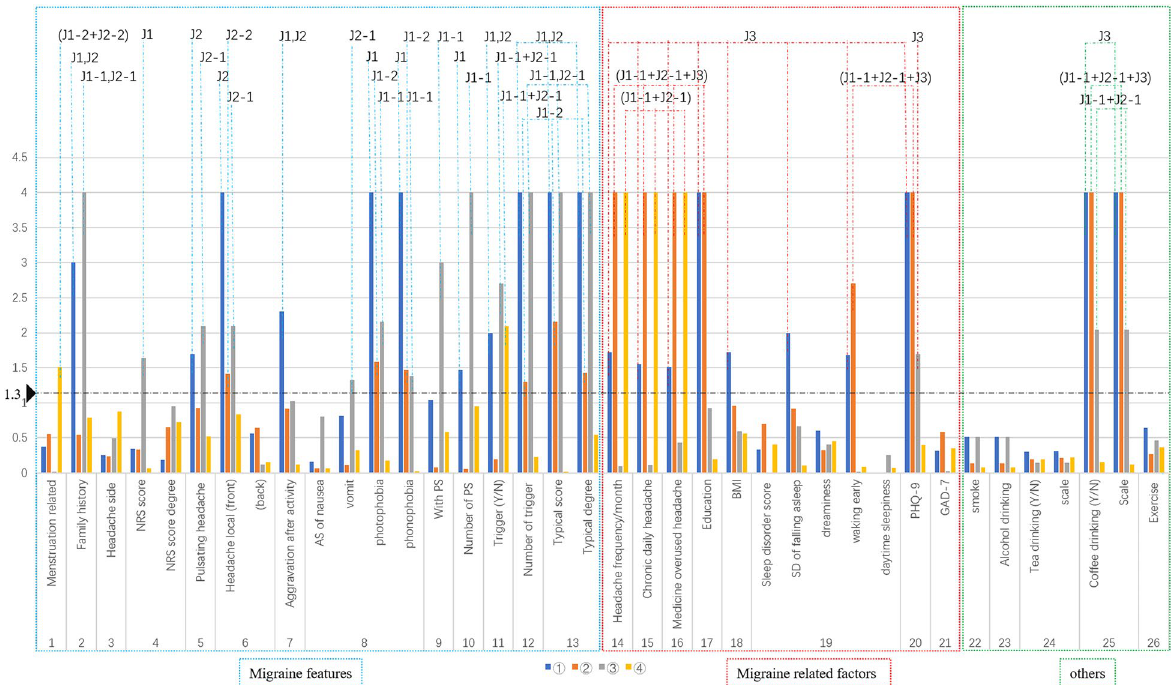
Fig. 4 The graph shows the main results of the comparison. In this study, the comparison project was broken up into four parts: ① J1 vs. J2 vs. J3, J2-1 J3), ③ J1-1 vs. J2-1 vs. J3, ④ (J1-1 J2-1) vs. (J1-2 J2-2). To visualize the significance of comparison results, the P ② J1-2 vs. J2-2 vs. (J1-1 + + + + value was transformed as minus lg P (the vertical axis of the graph) and displayed as bars with different colors representing different comparison parts: blue for part 1, orange for part 2, gray for part 3 and yellow for part 4 (details can be seen in Fig. 3). The horizontal axis lists compared items of migraine and migraine-related factors, which were divided into migraine features (enclosed by blue dotted line), migraine related factors (enclosed by red dotted line) and others (enclosed by green dotted line). P < 0.05 was defined as statistically significant. The minus Ig 0.05 was 1.3 (shown by the black arrowhead and dotted line). Every bar in the graph reflects the most or highest group of the comparison except consumption of coffee (reflecting the least), and the names of the group with P < 0.05 are labelled on the top of the